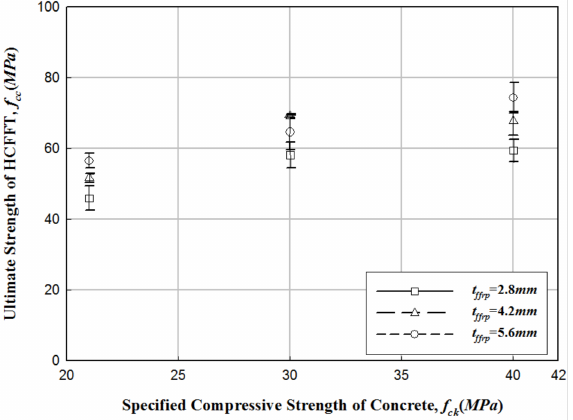
Figure 18. Average compressive strength of hybrid − CFFT with respect to the increase in the design strength of concrete.